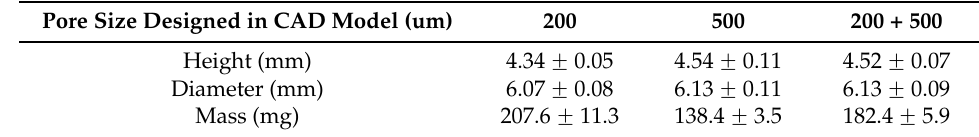
Table 4. The average dimensions and mass of fabricated scaffolds.